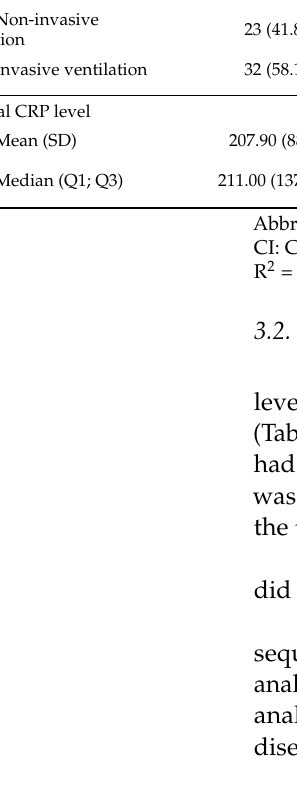
Table 5. Factors associated with